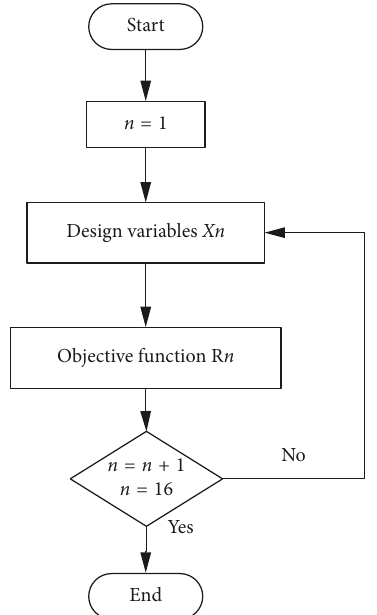
Figure 19: Flowchart of optimization analysis.